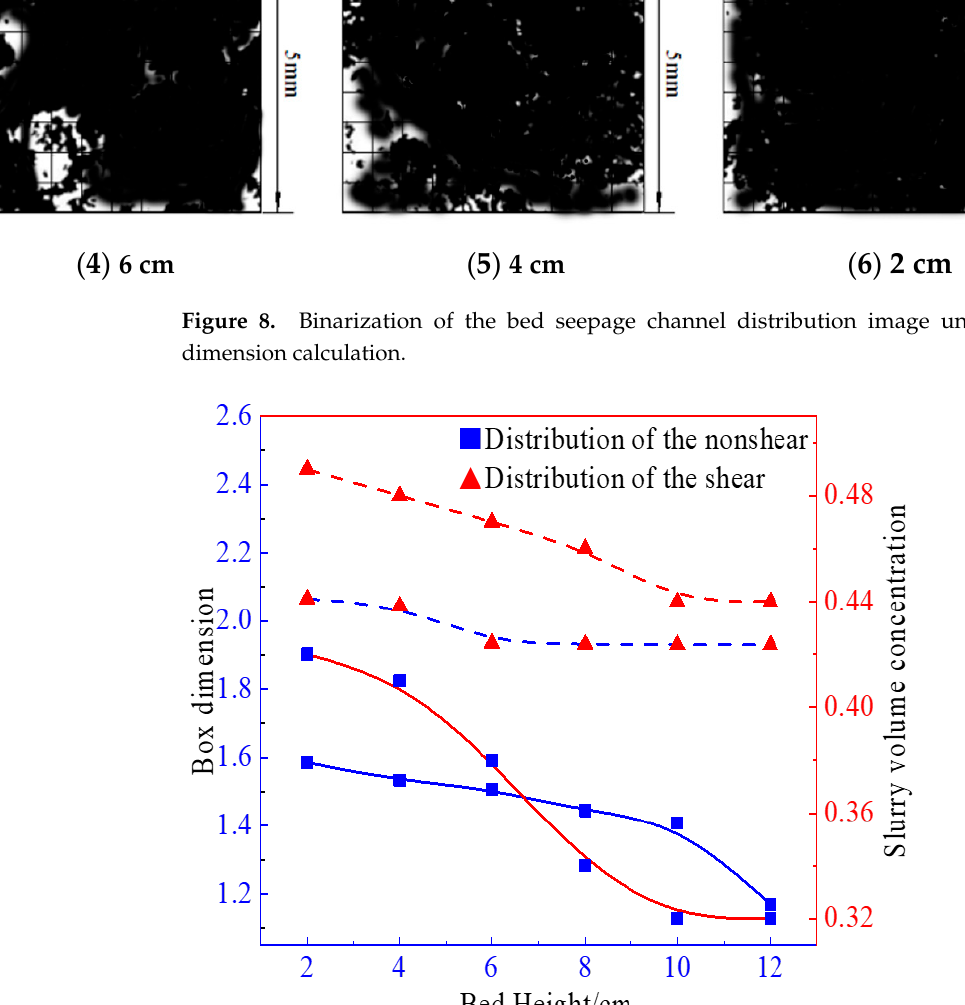
Figure 9. Fractal dimension and internal concentration distribution curves of seepage channels within the bed.